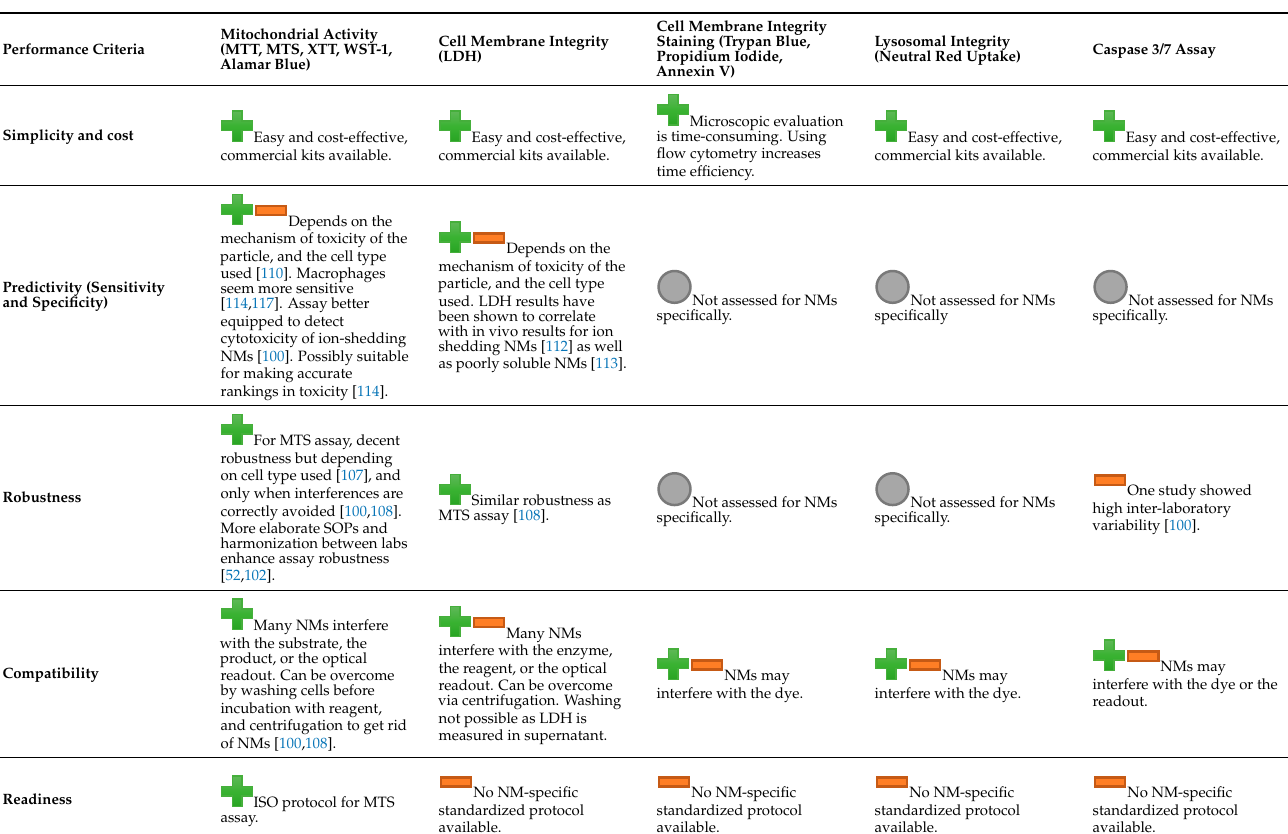
Table 1. Evaluation of suitability of cytotoxicity assays for SbD hazard testing.